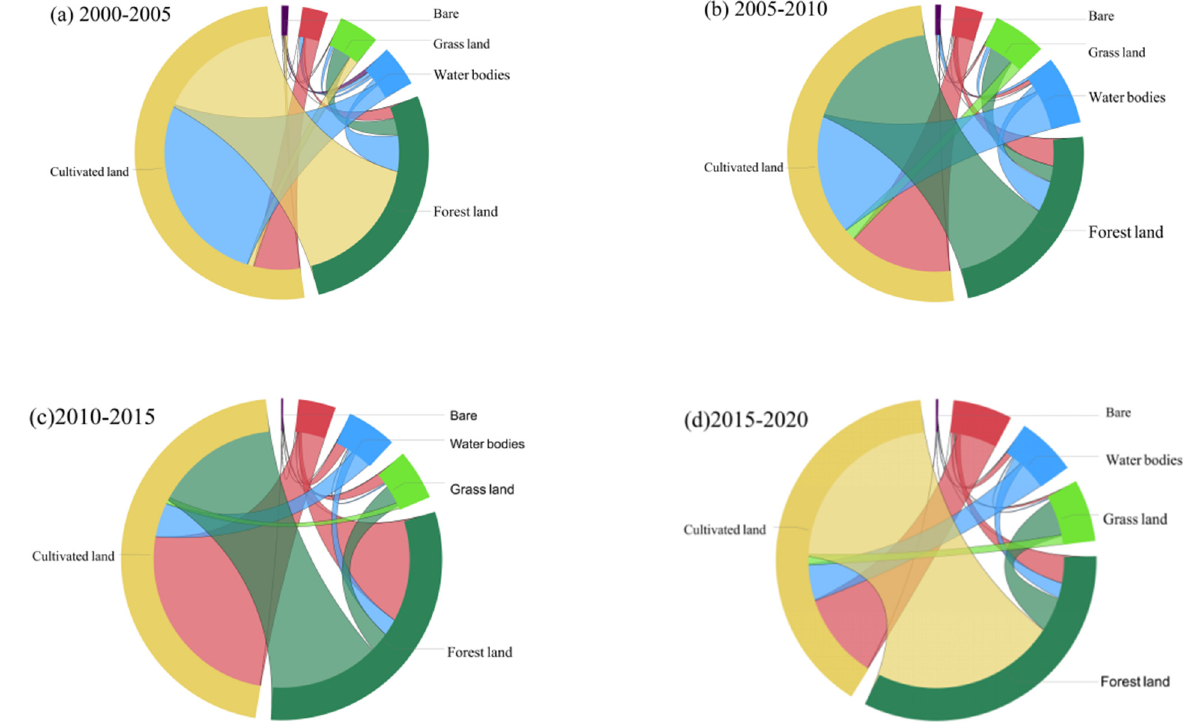
Figure 4. Land cover transition from ( a ) 2000–2005, ( b ) 2010–2010, ( c ) 2010–2015, ( d ) 2015–2020. The land use changes from 2000 to 2010 were not as drastic as the land cover changes from 2010 to 2020, but the conversion of cropland to forestland, built-up area, water area, and grassland took place in a large proportion. The 18 types of land use conversion units are sorted by area, and the total area of the first 9 types of conversion accounted for 90.72% of the total conversion area. The most obvious land type conversion is the interchange of cropland and forestland, which accounts for 50.52% of the converted area (Figure 4) and is distributed in the western mountainous area. “Cultivated land to built-up area” (C–BU in Figure 3), which accounts for 11.97% of the total converted area, is mainly distributed in the marginal area of the built-up area where land use changes are relatively drastic. Under the policy of increasing built-up land, the urbanization of western Hubei was fast. The decreased cropland was mainly used for built-up land. Before 2000, driven by the benefits of commercial grains, large areas of ecological land in western Hubei were reclaimed into cropland by local residents [61]. The national government has paid attention to this phenomenon and launched the “Grain for Green” project after 2000. Due to the implementation of the “Grain for Green” Project, in 2020, forestland increased by 6.7% (Figure 5). Among this increased forestland, 79.34% was transformed from cropland. Overall, the land use in western Hubei has undergone major changes from 2000 to 2020, which are mainly concentrated on the mutual conversion between cropland and forestland, grassland, built-up area, and waters. The expansion of built-up land and the “Grain for Green” project in ecologically fragile areas of central China exploited a large amount of cropland [40,62].